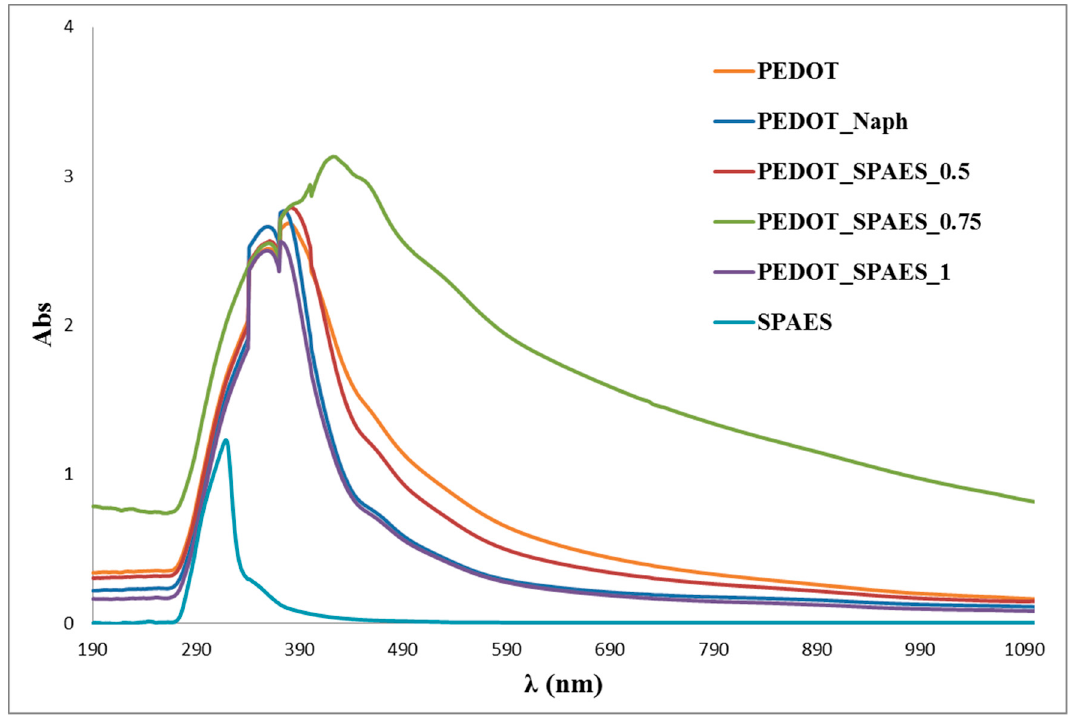
Figure A8. UV absorbance data of PEDOT, PEDOT_Naph, PEDOT_SPAES, and SPAES samples synthesized in DMAc.